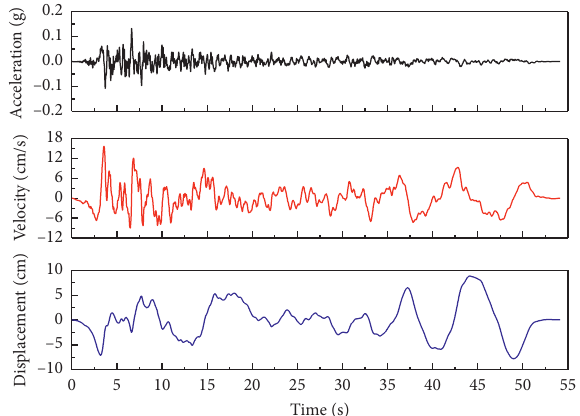
Figure 7: Time histories of the Taft